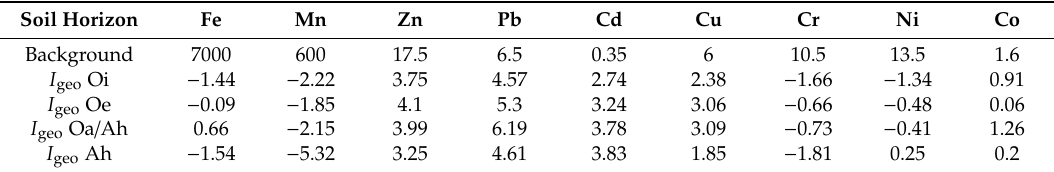
Table 4. Background values of elements (mg · kg − 1 ) commonly found in limestone and dolomites according to Kabata-Pendias and Pendias [39] and geoaccumulation index (Igeo) calculated for the upper horizons of soil.